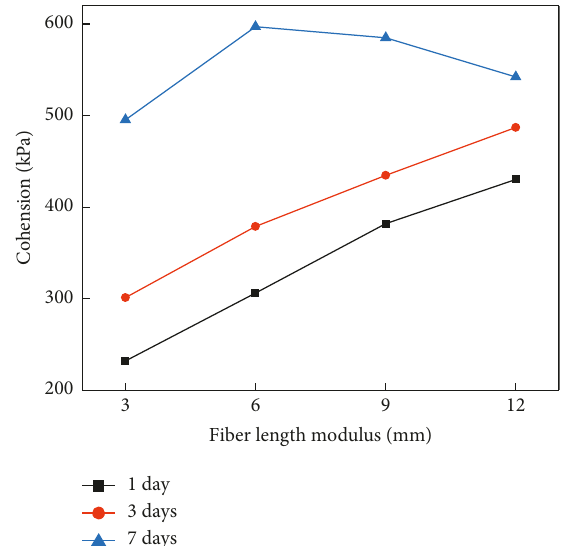
Figure 4: Variation of the water content of cured remolded soil with fiber admixture at different curing times.